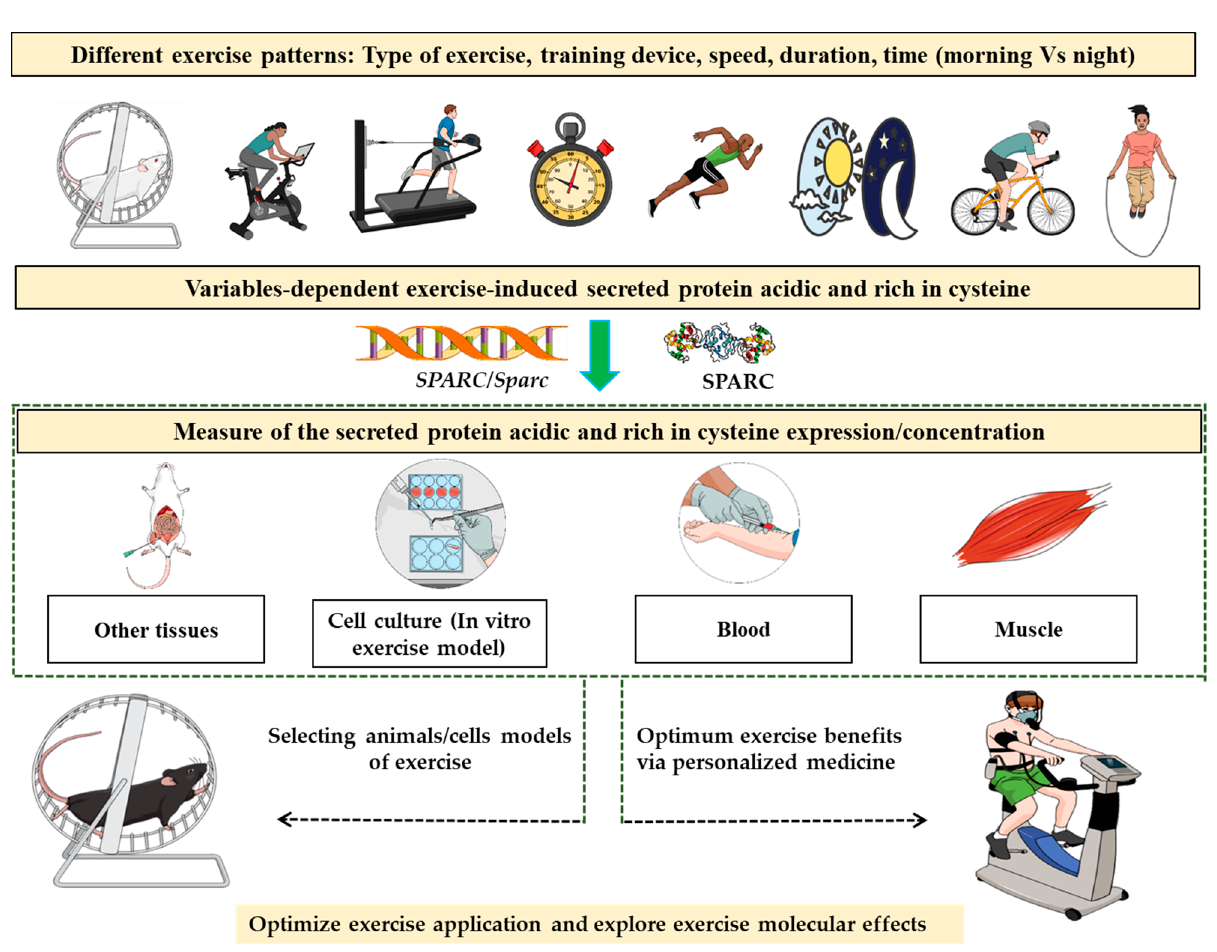
Figure 1. Measuring secreted protein acidic and rich in cysteine expression/concentration in biological samples following different patterns of exercise training would reflect the biological “responsiveness” to the physical activity and would predict the intensity of the benefits that exercise-induced changes will have. Such a property could be explored for instance to optimize the prescribed physical activity towards a personalized medicine approach and also select animal/cell models of exercise.